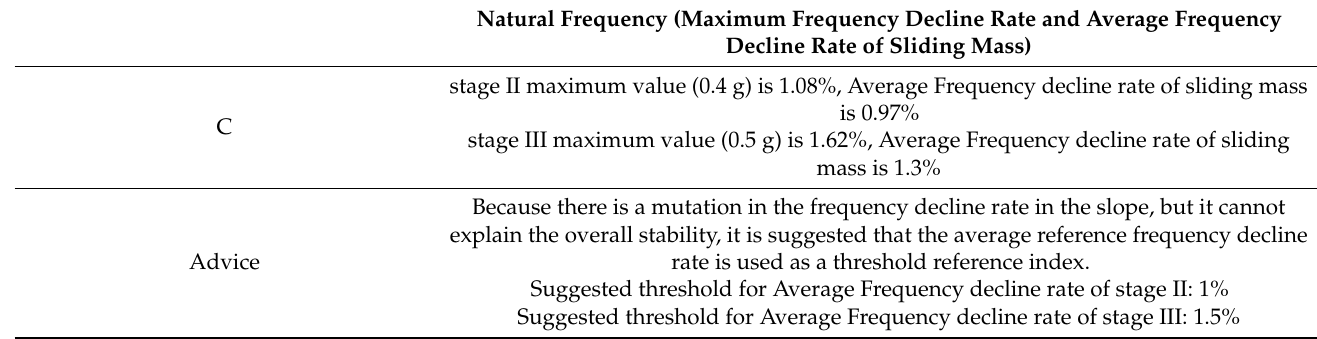
Table 9. Cont. Natural Frequency (Maximum Frequency Decline Rate and Average Frequency Decline Rate of Sliding Mass)